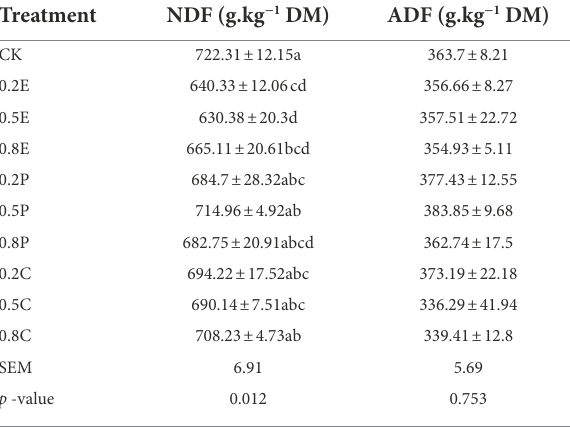
TABLE 4 Chemical composition of paper mulberry silage at 60 days.